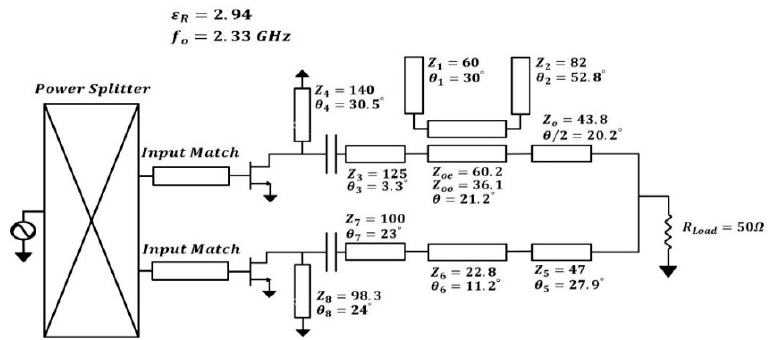
Figure 14. Schematic for the proposed Doherty output power combiner. Electronics 2018 , 7 , x FOR PEER REVIEW